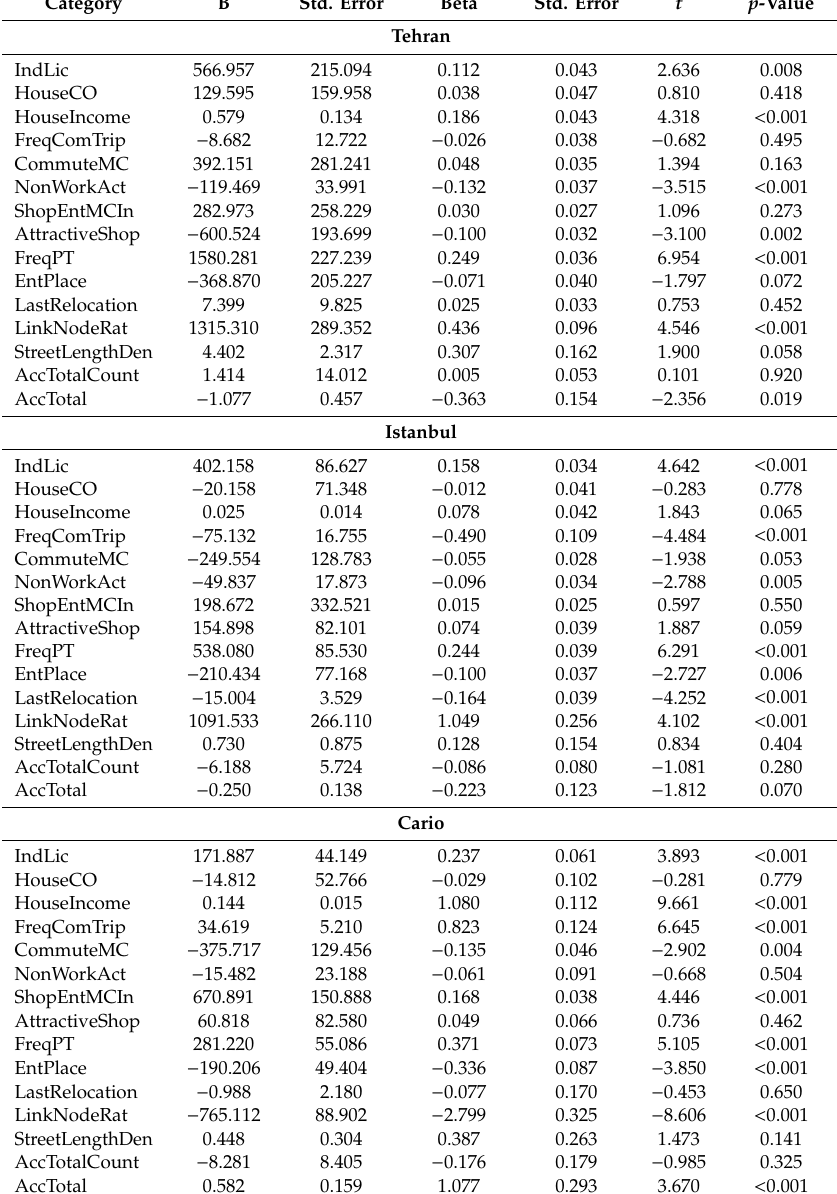
Table 6. WLS model estimates for Tehran, Istanbul, and Cairo.